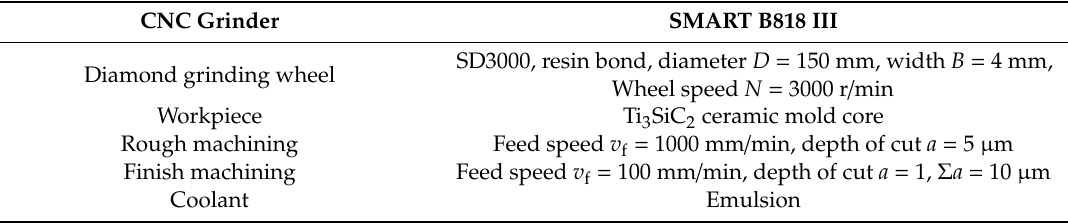
Figure 1. Micro-grinding machining scheme and photo of mold core: ( a ) Schematic diagram of V-grooved structures machining; ( b ) Photo of micro-grinding. Table 1. Micro-grinding conditions of mold core using a V-tip diamond grinding wheel.